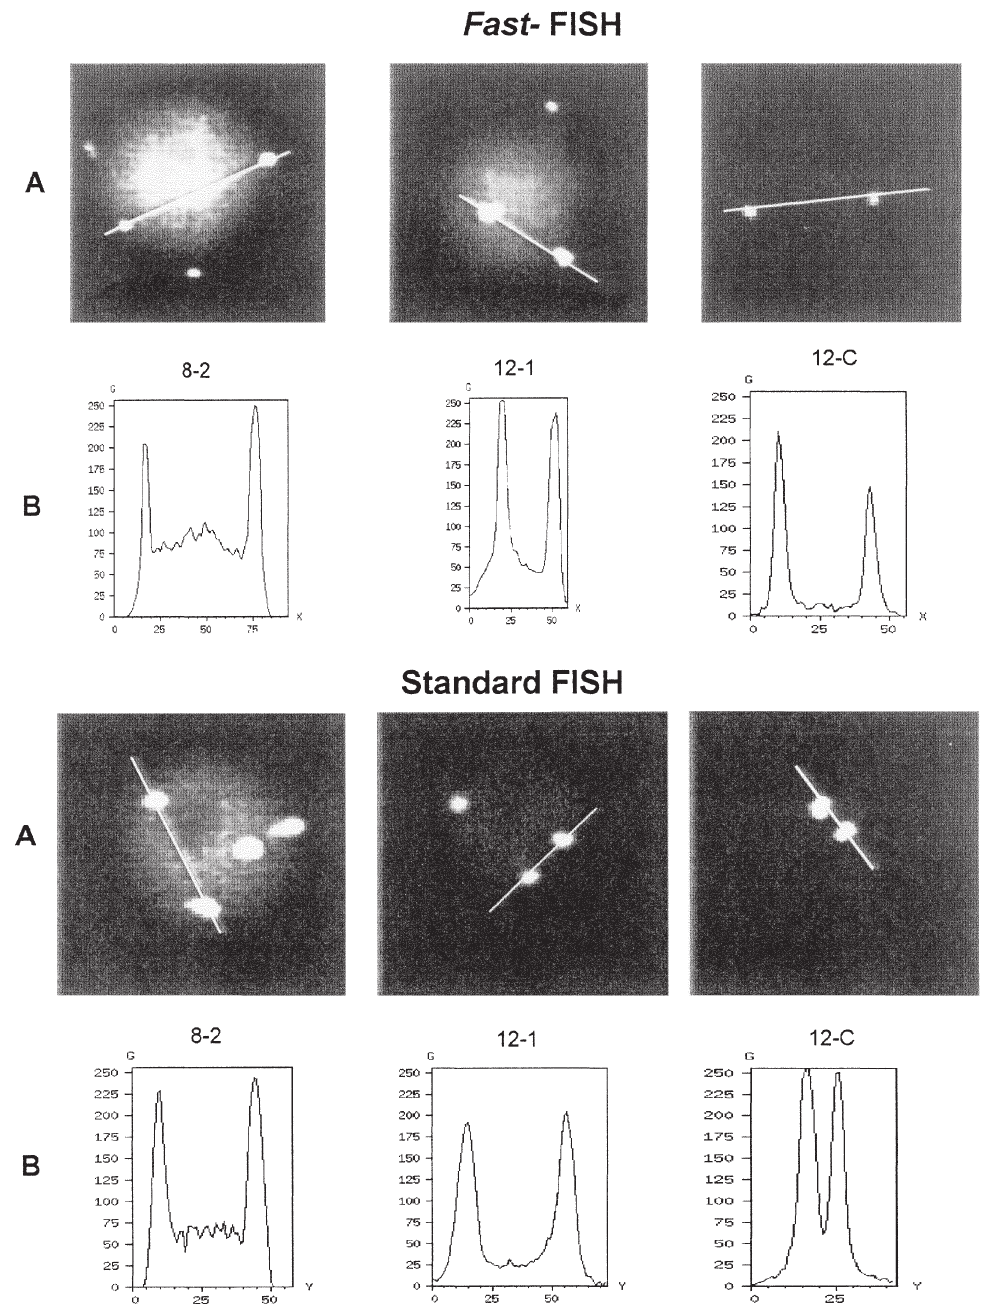
Fig. 2. (A) Digitized images of typical cell nuclei of the patients 8-2 (AML with tetrasomy 8), 12-1 (B-CLL with trisomy 12), and 12-C (no numerical aberration of chromosome 12) after Fast -FISH and standard FISH. (B) Intensity profiles from the green image plane along the scan lines indicated in (A). The ordinate shows gray values in arb. units. On the abscissa the length of the scan in arb. units is